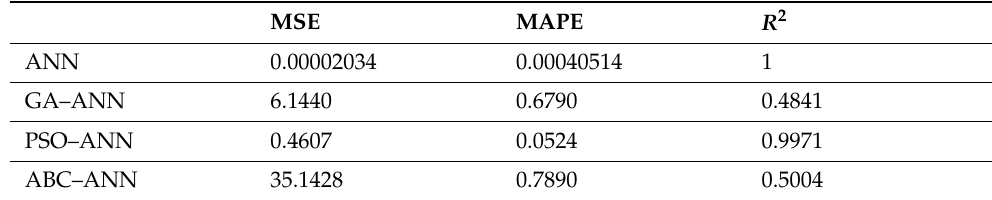
Table 3. Numerical comparison of